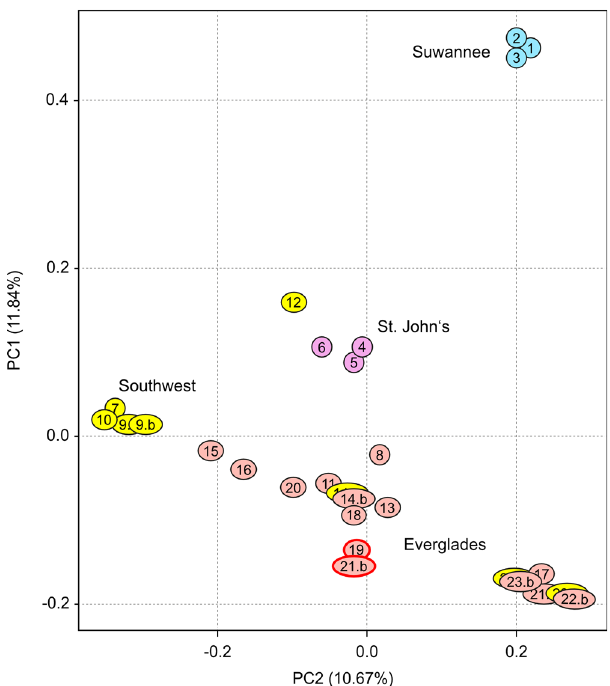
Fig. 2 Principal component analysis, based on linkage-pruned variant sites ( N = 76,863) obtained from the Procambarus fallax whole-genome sequencing dataset. Colors indicate the four major subpopulations: Suwannee (blue), St. John ’ s (purple), Southwest (yellow), and Everglades (red). Closely overlapping red/yellow ovals represent independent animals collected from the same location ( “ a ” and “ b ” ). Animals that are particularly closely related to P. virginalis are highlighted by red ovals.